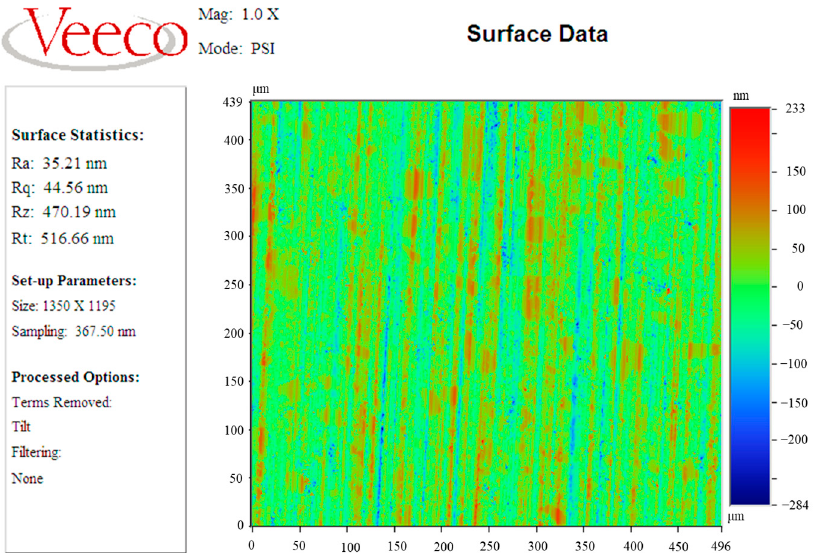
Figure 20. Roughness of SiC aspheric mirror after grinding.